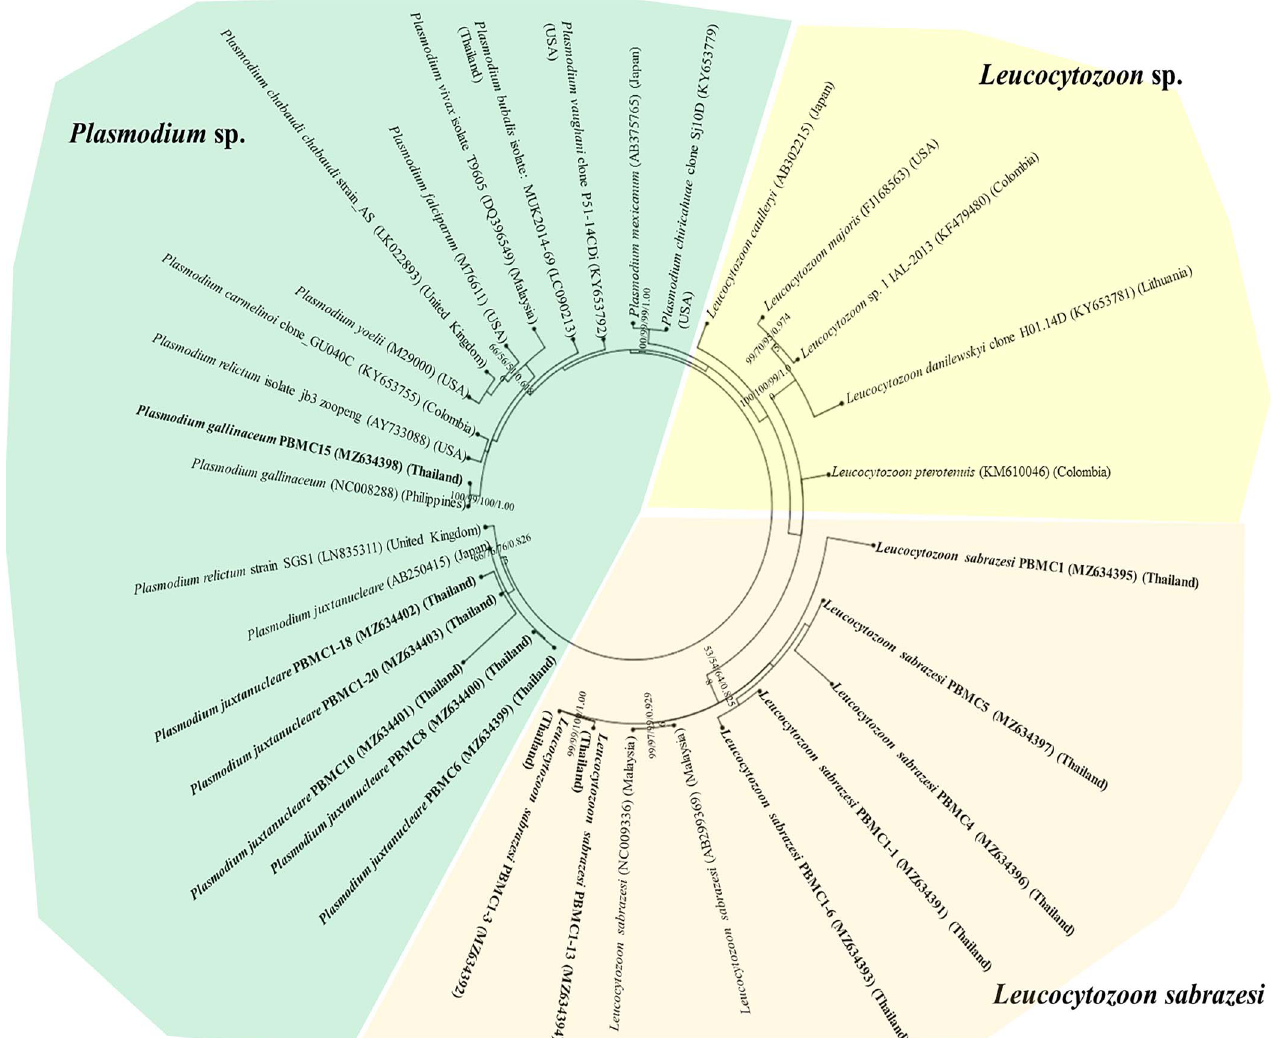
Fig. 2. Phylogenetic tree of the coxI gene sequences in this study (bold face) and those obtained from GenBank. The boostrap values calculated from NJ, ML, MP and BA are labeled on each